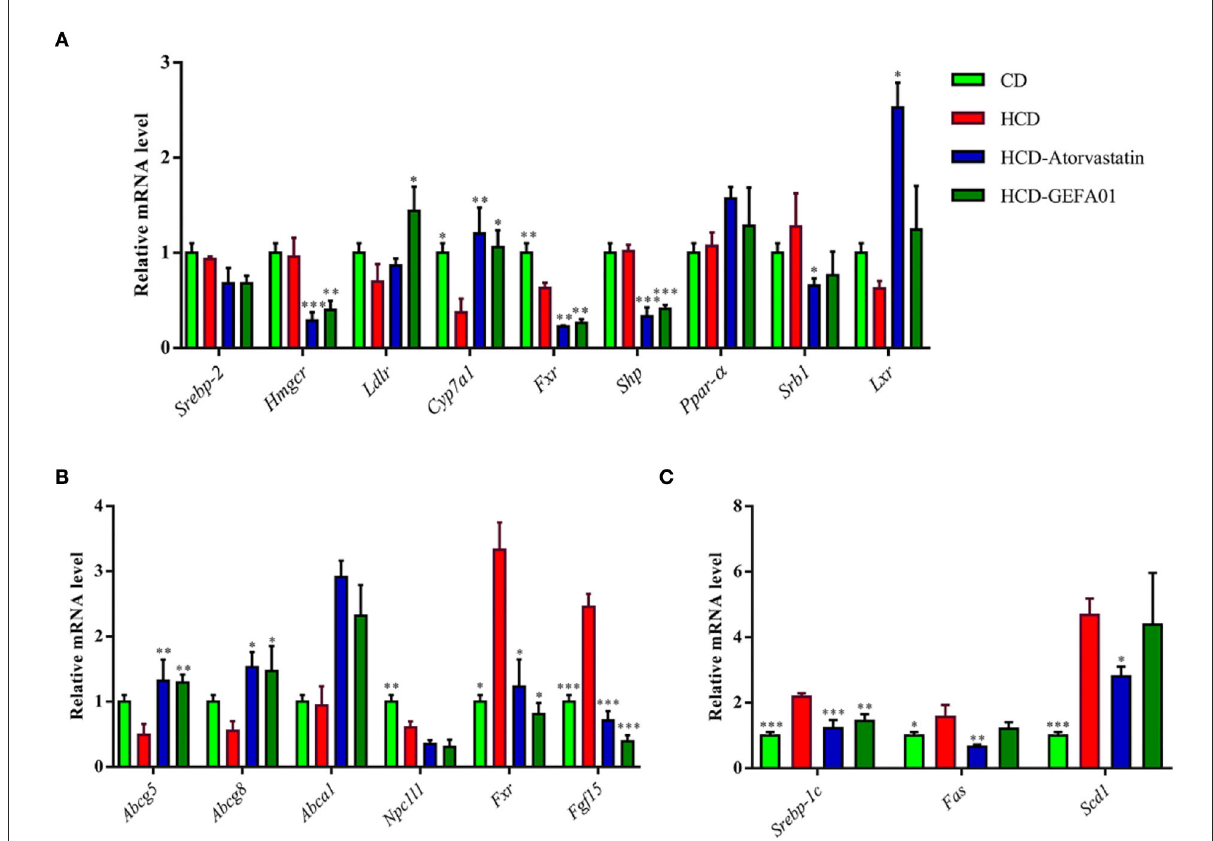
FIGURE5 E. faecium GEFA01 regulated the expression of genes associated with lipid metabolism in hypercholesterolemic mice. (A) The effects of E. faecium GEFA01 on the expression of key genes involved in bile acid and cholesterol metabolism of the liver; (B) the effects of E. faecium GEFA01 on the expression of key genes about cholesterol absorption and efflux metabolism of the ileum; and (C) the expression of regulators related to lipid synthesis at messenger ribonucleic acid (mRNA) levels using RT-qPCR. Data were expressed as mean ± SEM: n = 3 animals per group; * p < 0.05, ** p < 0.01, *** p < 0.001, all groups were compared to the HCD